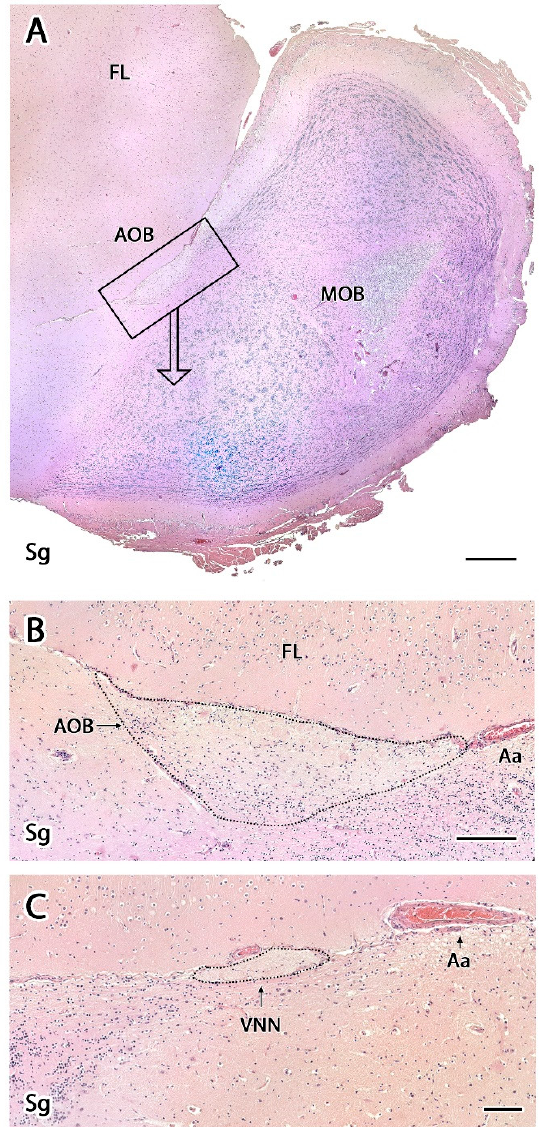
Figure 3. Sagittal sections of the olfactory bulbs of the meerkat stained with Hematoxylin-eosin. ( A ) Sagittal section of the rostral portion of the brain of the meerkat. The frontal lobe (FL), the main olfactory bulb (MOB), and the location, in the caudal part of the MOB, of the accessory olfactory bulb (AOB) are shown. ( B ) Higher magnification of the box in ( A ) showing the AOB. Following the course of the vomeronasal nerve throughout the sagittal histological series, we arrived at the area bordered by the dotted line that corresponds to the AOB. Its size is relatively small and its lamination, diffuse. It is better discriminated with the Nissl stain (Figures 4 and 5). ( C ) A more medial sagittal section than B shows the arrival of the vomeronasal nerve through the medial surface of the main olfactory bulb in direct topographical relationship to a large-caliber artery (Aa). Scale bars: ( A ): 600 µ m. ( B ): 200 µ m. ( C ): 100 µ m. VNN, vomeronasal nerve, Sg,